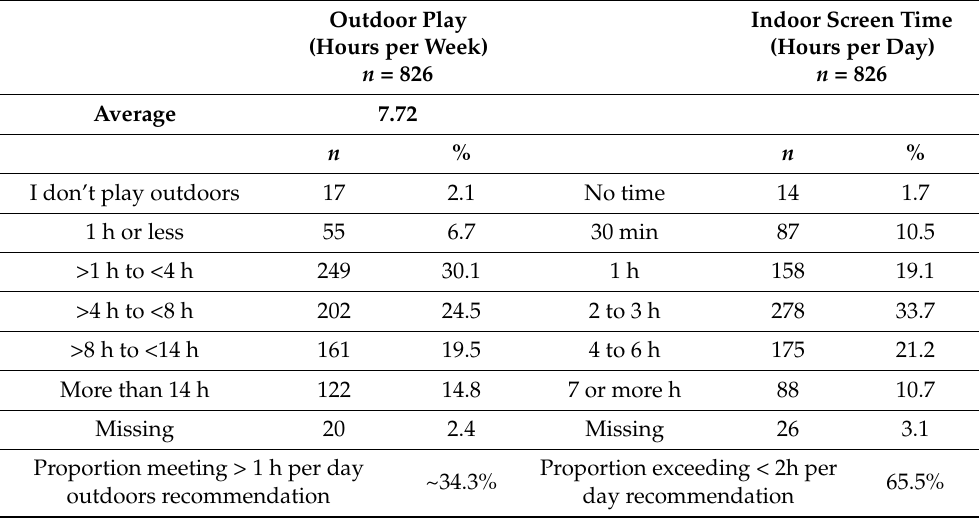
Table 2. Participant Children’s Time Outdoors and On Screens.